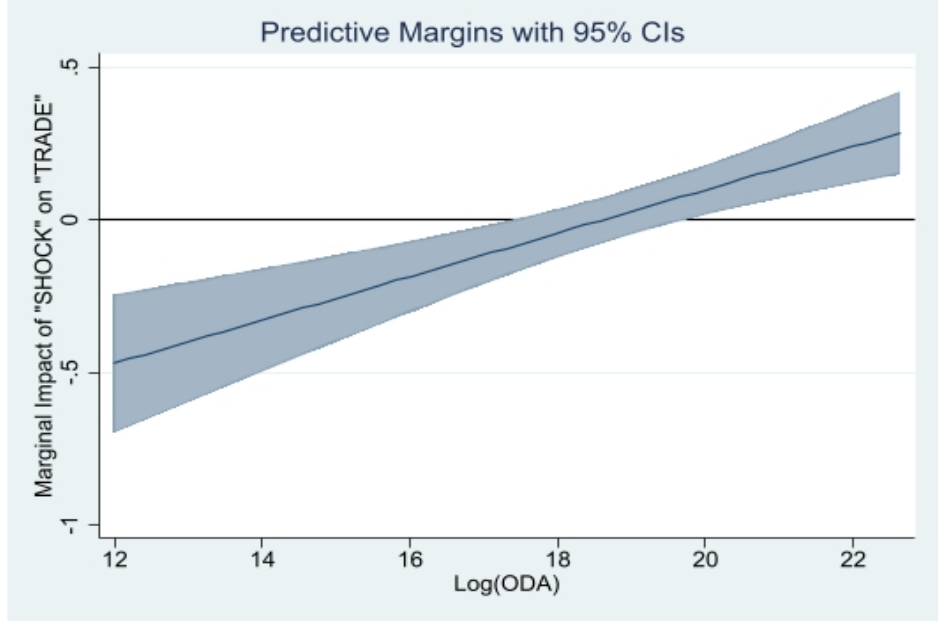
Figure 14. Marginal impact of “SHOCK” on “TRADE” for varying amounts of development aid. Source: